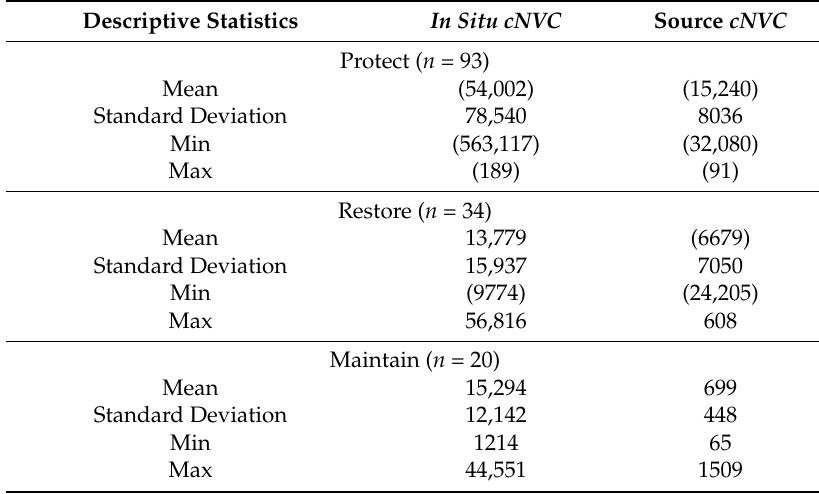
Table 7. Summary statistics for POD-level in situ and source risk calculations, quantified in terms of conditional net value change (cNVC), and broken down according to response category; values presented in parentheses are